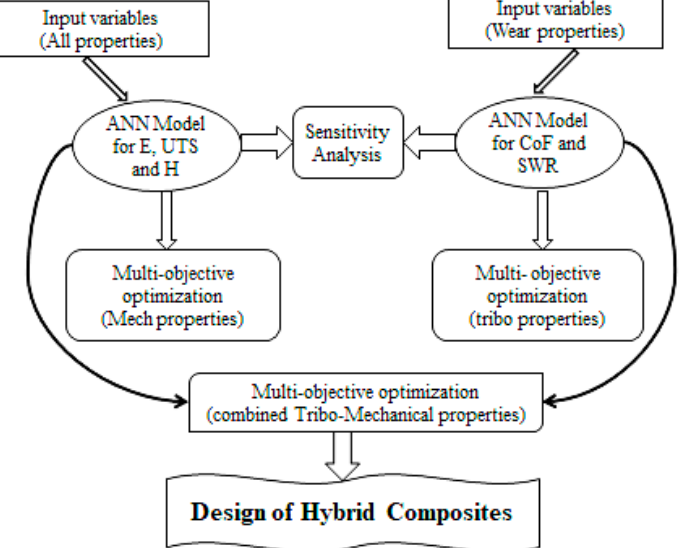
Figure 2. Process flowchart of the computational arrangement.